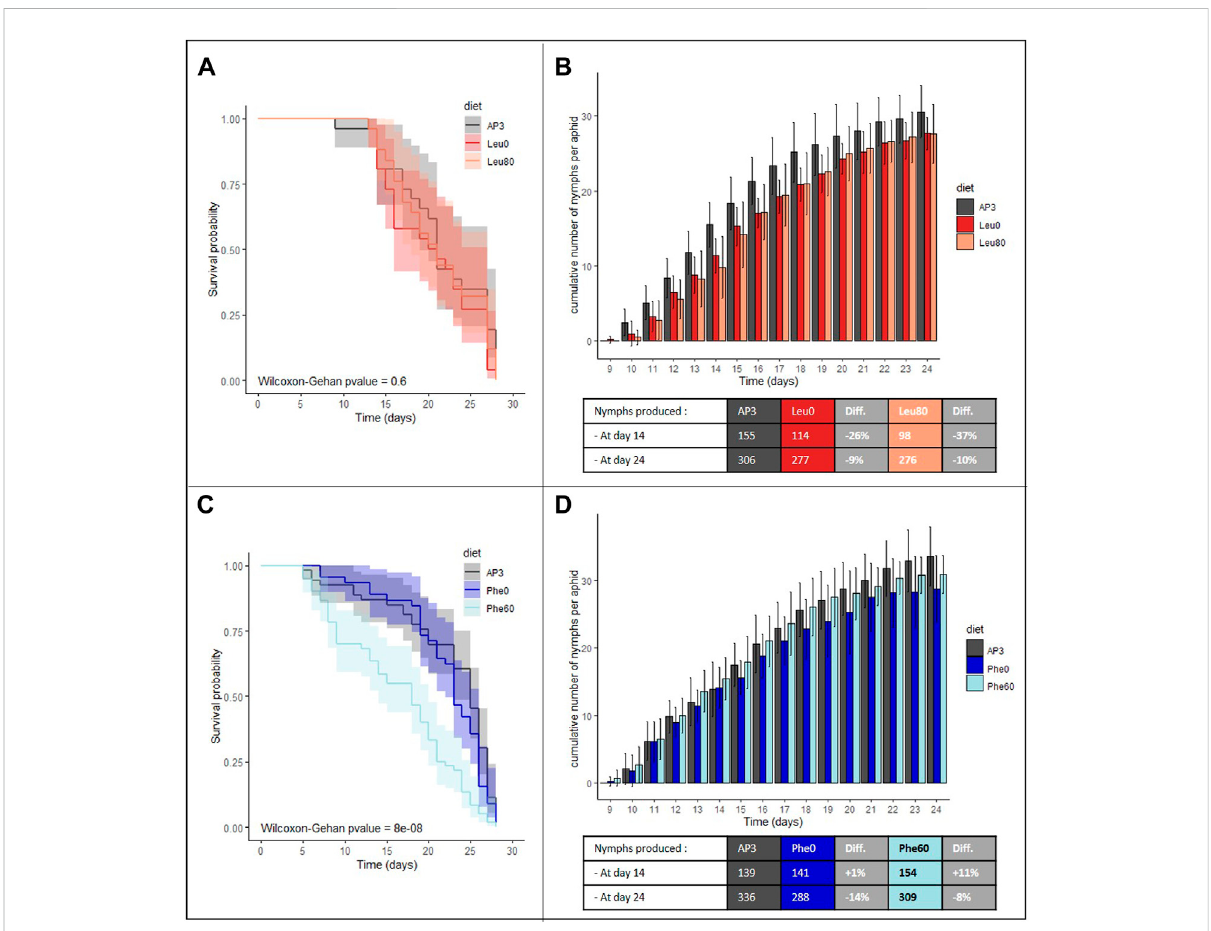
FIGURE 1 Impact of depletion or excess of leucine and phenylalanine on aphid survival and fecundity. (A,C) Survival analysis of A. pisum reared on the following arti fi cial diets: a complete diet (AP3, dark gray), a leucine or phenylalanine depleted diet (Leu0, red or Phe0, dark blue) and a diet with leucine or phenylalanine excess (Leu80, orange or Phe60, light blue). For each diet group, survival curves are displayed with their predicted con fi dence intervals. Each diet group was composed of 60 aphids. Data were analyzed using the Wilcoxon-Gehan Test. (B,D) Cumulative numbers of progeny per aphid reared on theAP3, Leu0, Leu80, Phe0 or Phe60 diets, throughout theaphid reproductive phase. Resultsare reported as means (±SD) of 10 isolated individuals per diet. The number of cumulative nymphs produced at day 14 and day 24 for each diet are indicated beneath the corresponding graph with information on the difference between control and stressed population. Abbreviation: Diff,